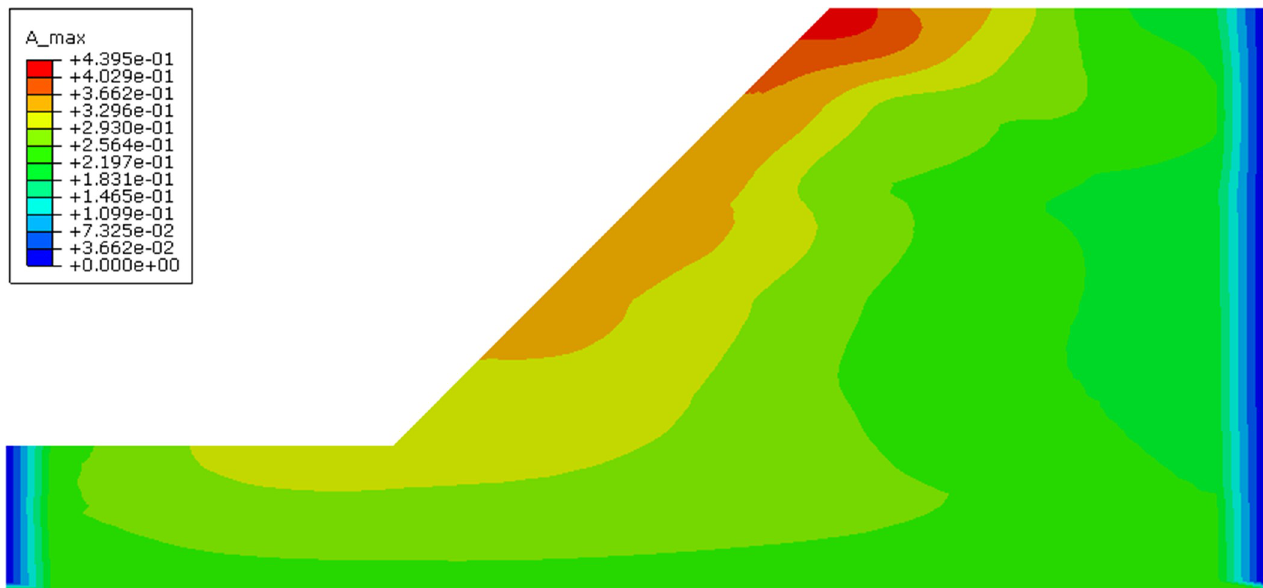
Fig 9. The horizontal acceleration contour map under the far-field seismic excitation (Unit: m.s -2 ).